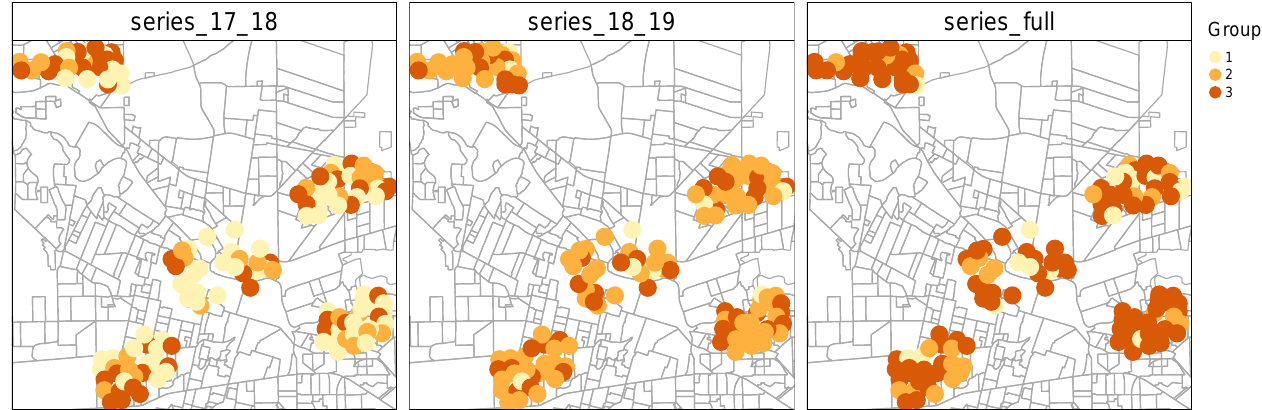
Figure 3. Spatial distribution of time series clustering results for the different periods studied. Left panel: season 2017–2018, central panel: season 2018–2019 and, right panel: full period